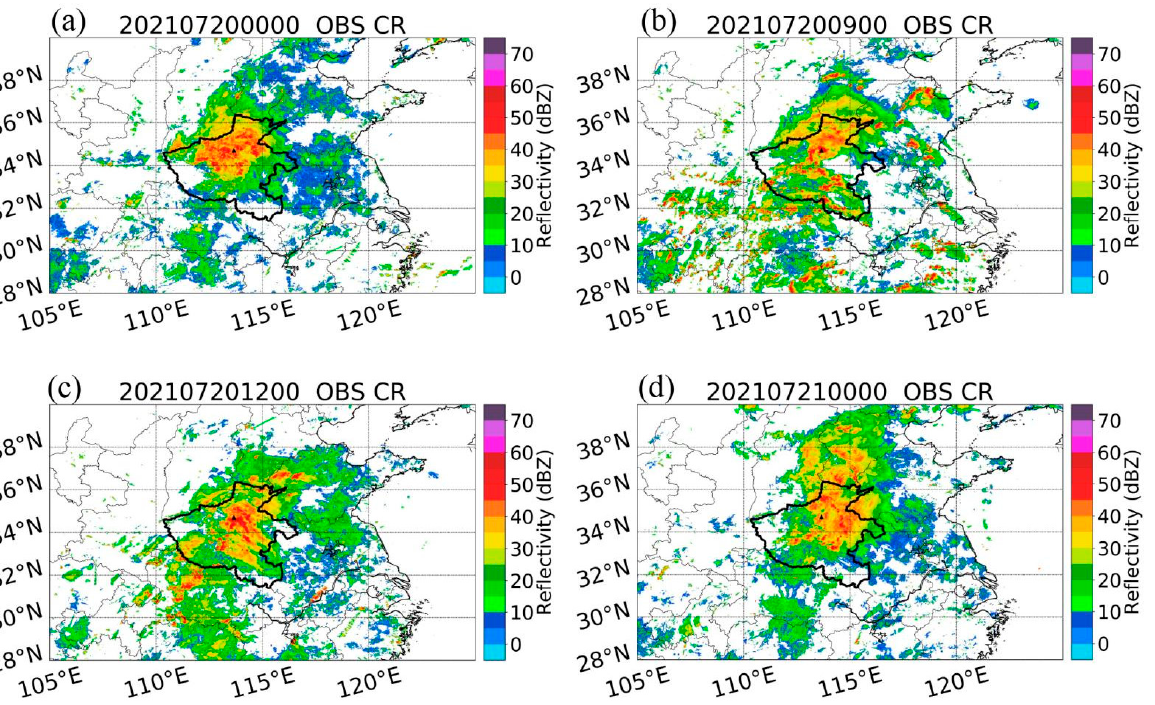
Figure 3. Radar composite reflectivity (dBZ) observed on 20 July 2021. The black triangle indicates the location of Zhengzhou national meteorological station. ( a – d ) correspond to 0000 UTC, 0900 UTC, 1200 UTC, and 2400 UTC on 20 July, respectively, and the Zhengzhou station is marked with a black triangle.